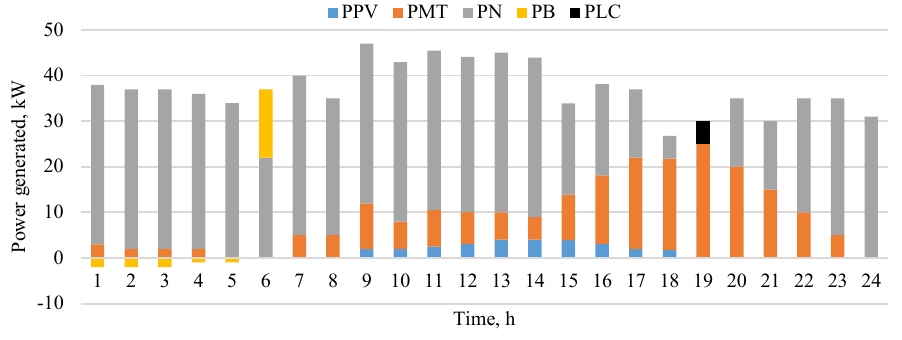
Fig. 8. Output power of each components and network in scenario